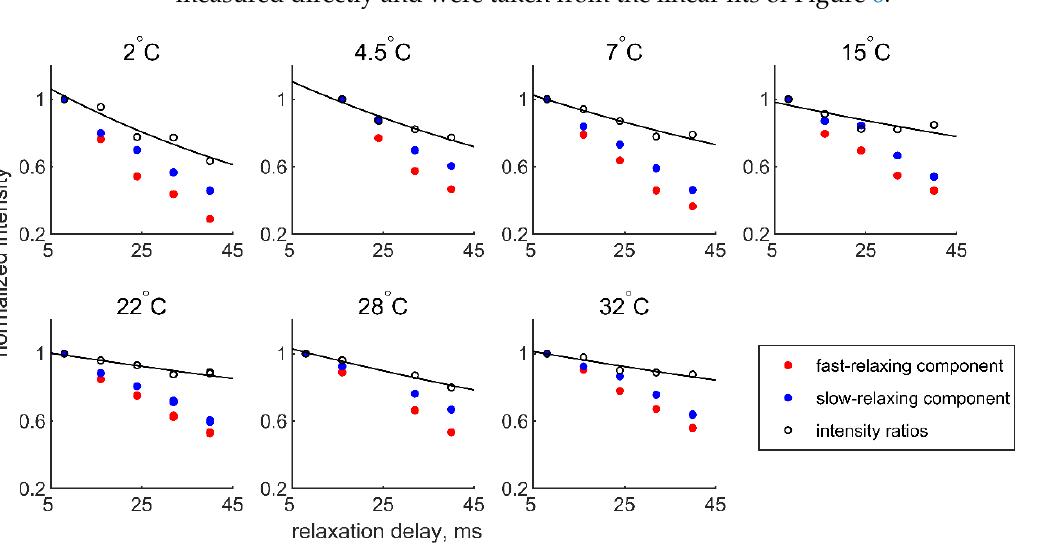
Figure 7. Representative cross-correlated (methyl dipole-dipole H i − H j /H i − C) relaxation decays for the L63-δ 1 site in the absence of glycerol at all temperatures. Intensities for the fast- and slowly- relaxing components (red and blue circles, respectively) as well as the corresponding ratios (open black circles) of the two components normalized to the shortest relaxation delay of 8 ms. The curves show monoexponential fits.